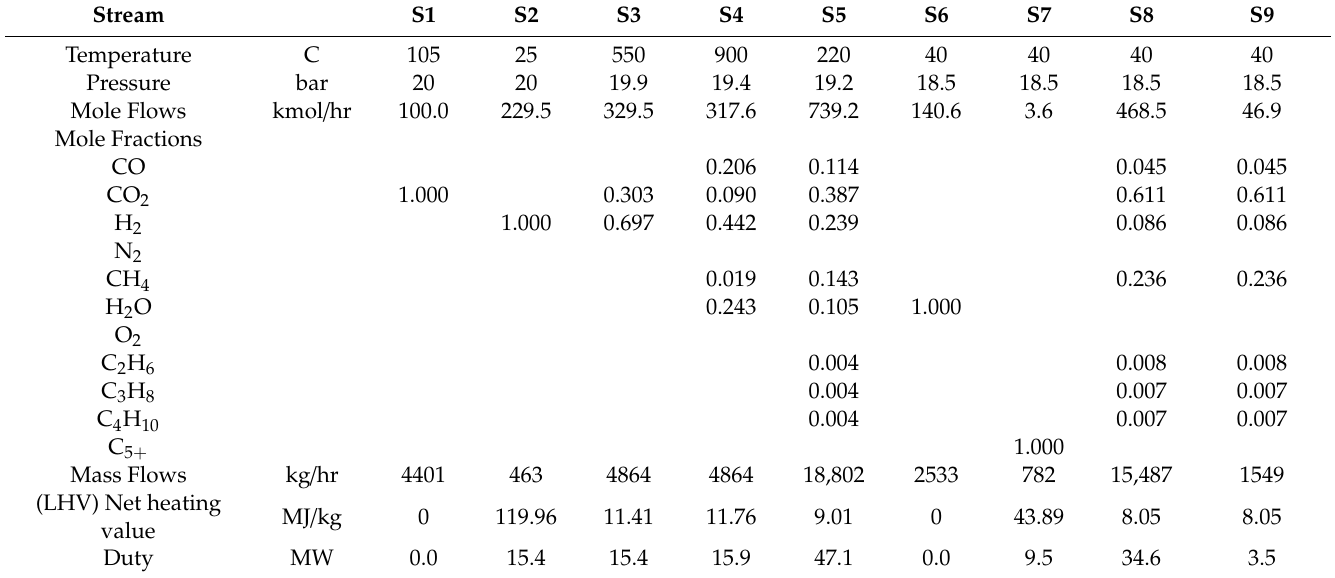
Table A3. Simulated stream results for